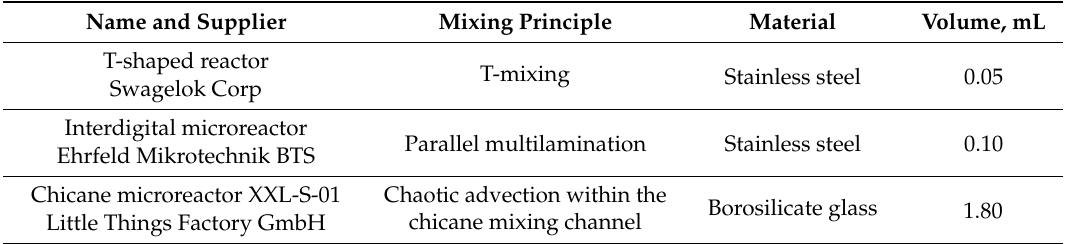
Figure 1. Experimental setup for the continuous saponification of ethyl acetate: ( a ) T-shaped reactor, interdigital microreactor or chicane microreactor; ( b ) conductivity cell; ( c ) residence time unit. Table 1. Specification of investigated reactors.